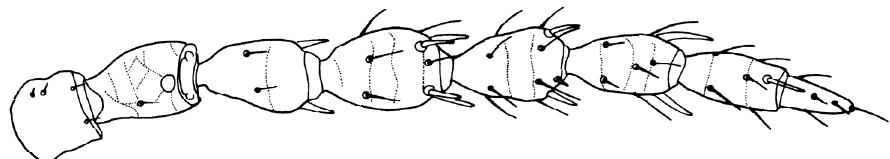
Figures 4. Haplothrips shivendraii sp. n.: Antenna,